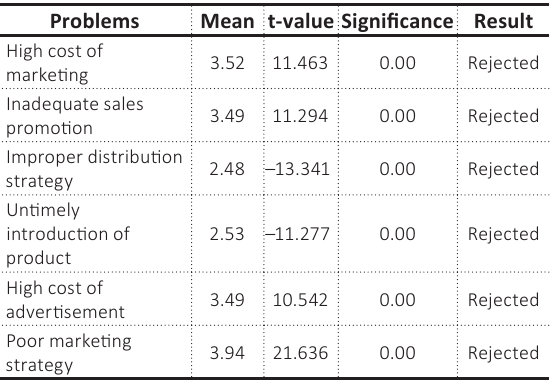
Table 8. Marketing challenges